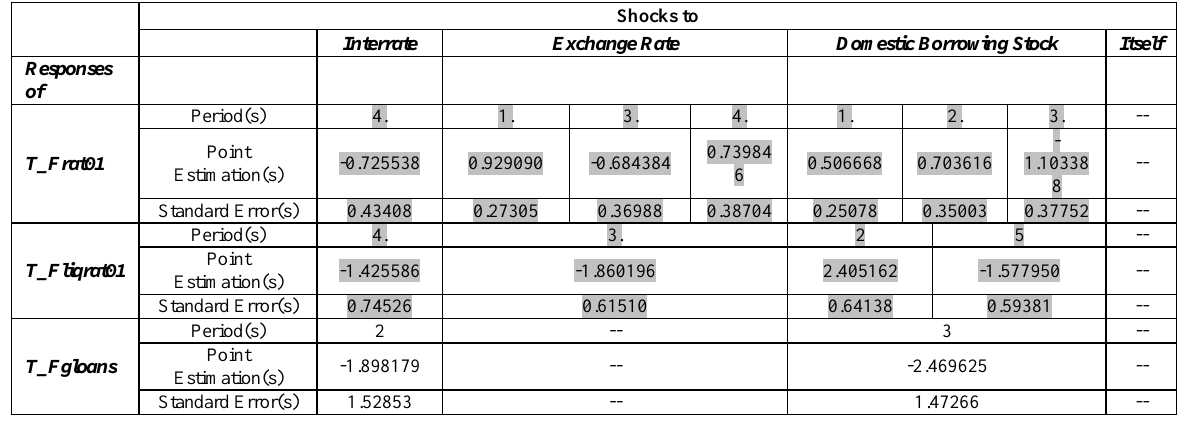
Table 5. The Summary of the IRFs of TBS (Excluding Foreign Banking